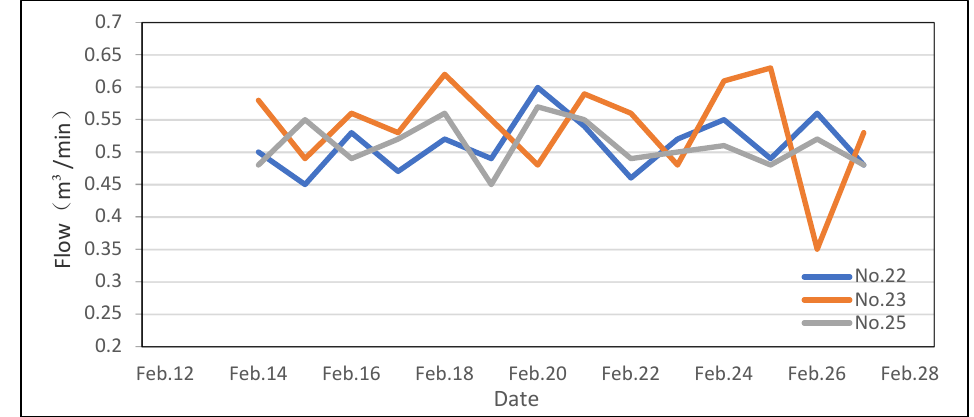
Figure 14. Gas drainage flow curve of some reverse boreholes.